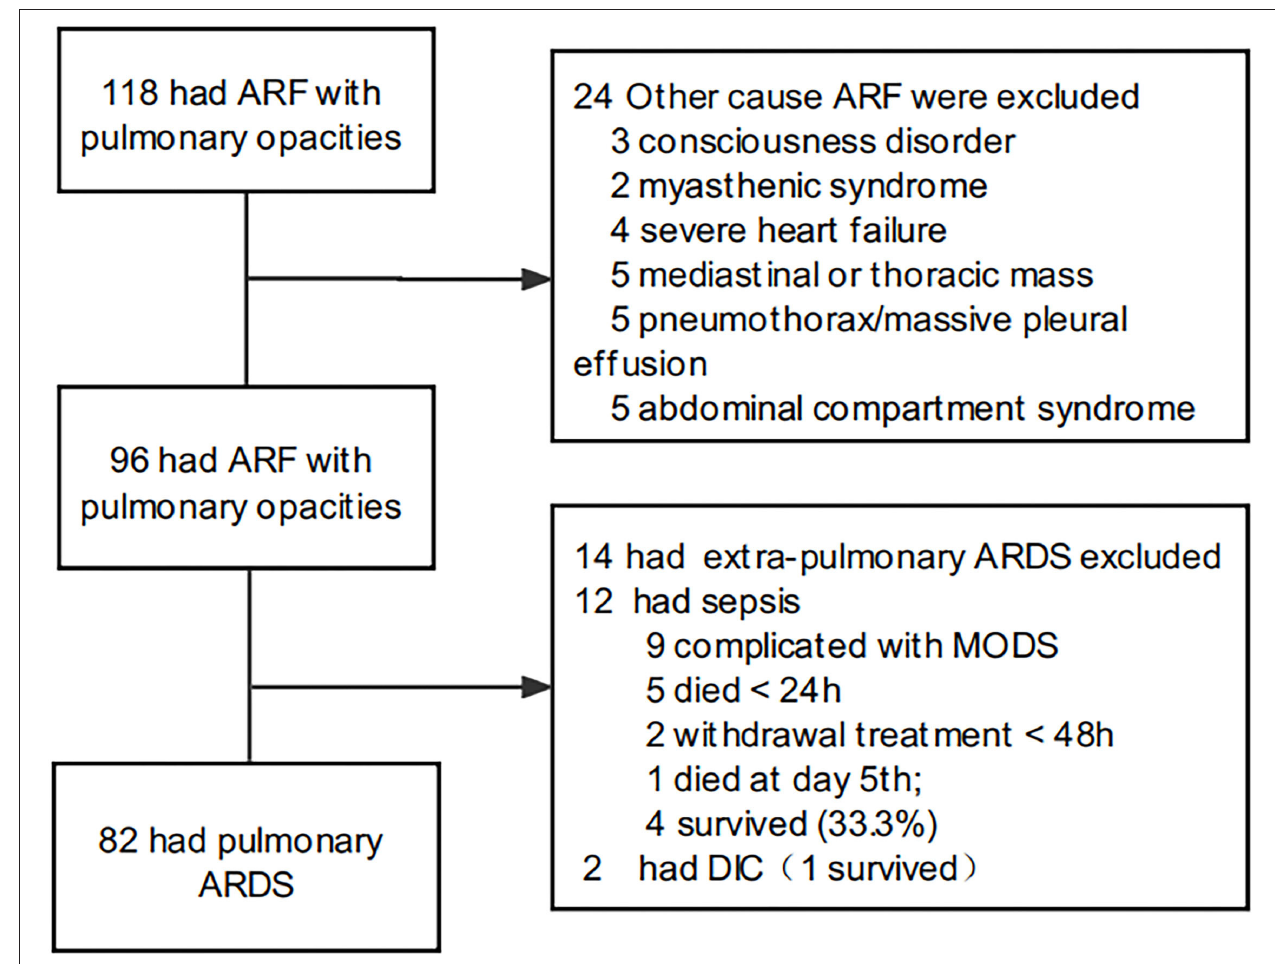
FIGURE 1 | Flow chart concerning ARDS inclusion. ARF, acute respiratory failure; ARDS, acute respiratory distress